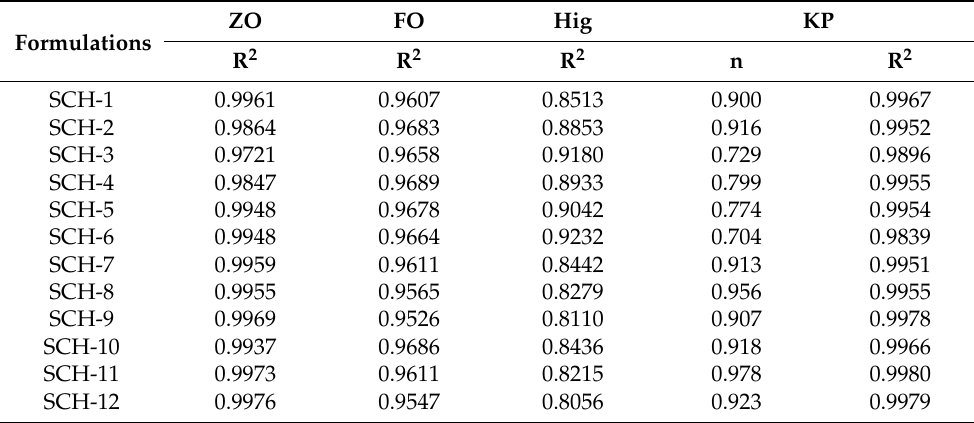
Table 3. Results of Kinetic modeling on release data (SCH-1 to SCH-12) .